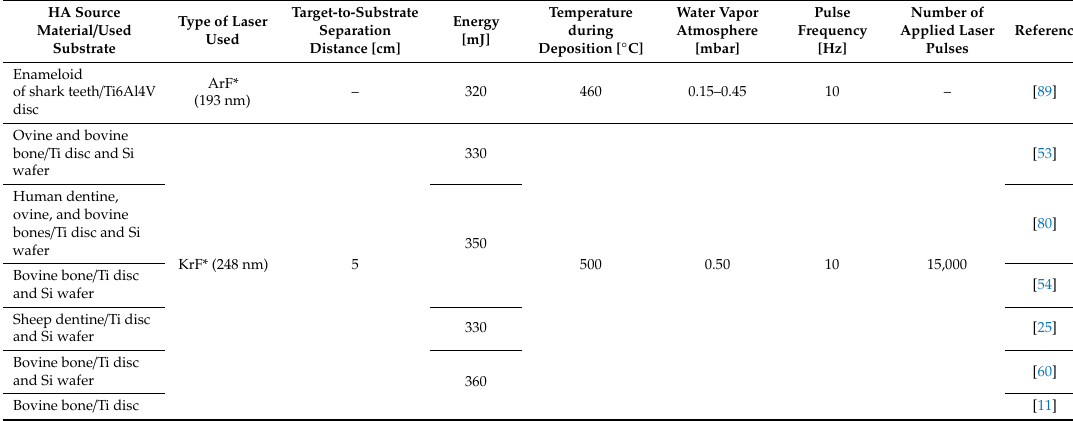
Table 6. Di ff erent experimental conditions used for PLD synthesis of BioHA Table 6. Different experimental conditions used for PLD synthesis of BioHA coatings.